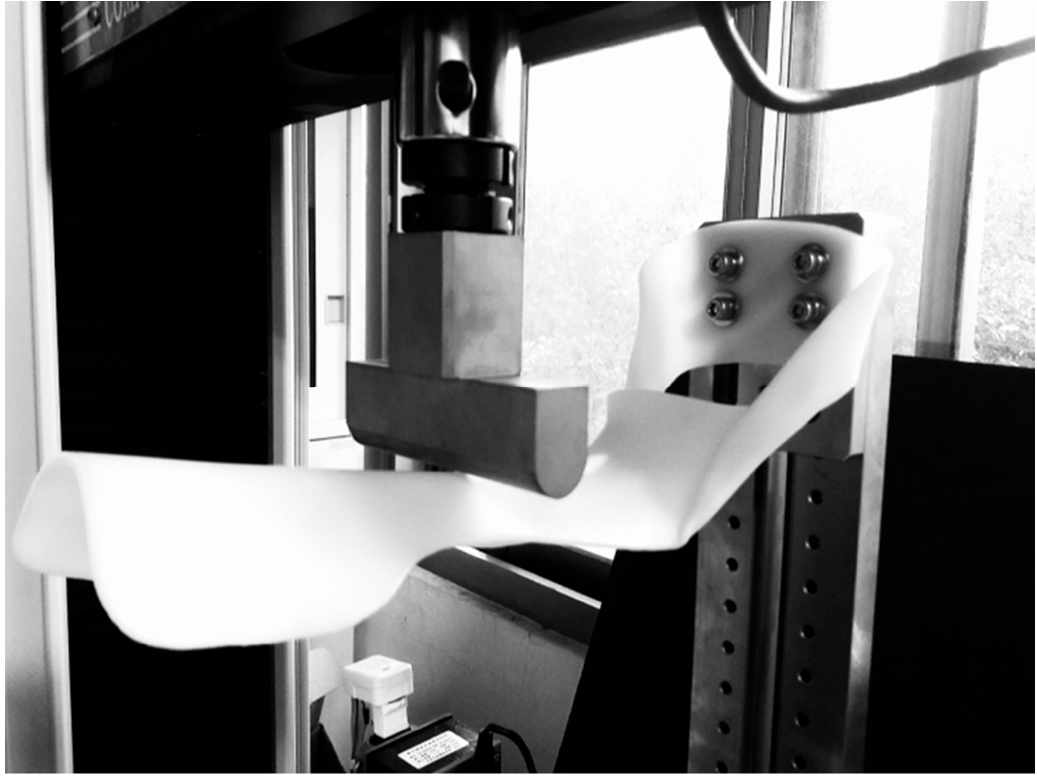
Figure 2. Mechanical testing of the AAFO in the simulation of plantarflexion.